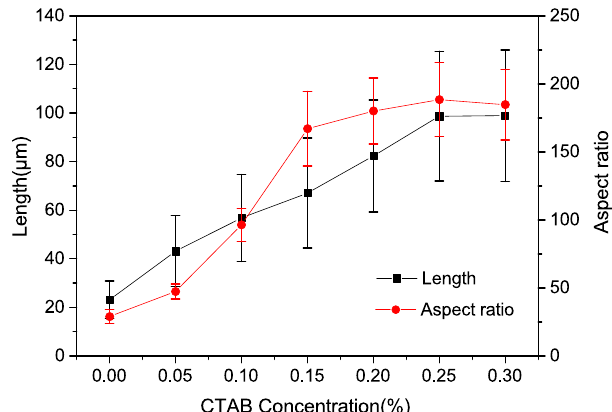
Figure 5. Average length and aspect ratio of α -HH whiskers prepared with different CTAB concentrations in glycerol (65 wt%)-water solutions with 5% KCl (by weight of FGD gypsum) at 90 °C for 45 min.